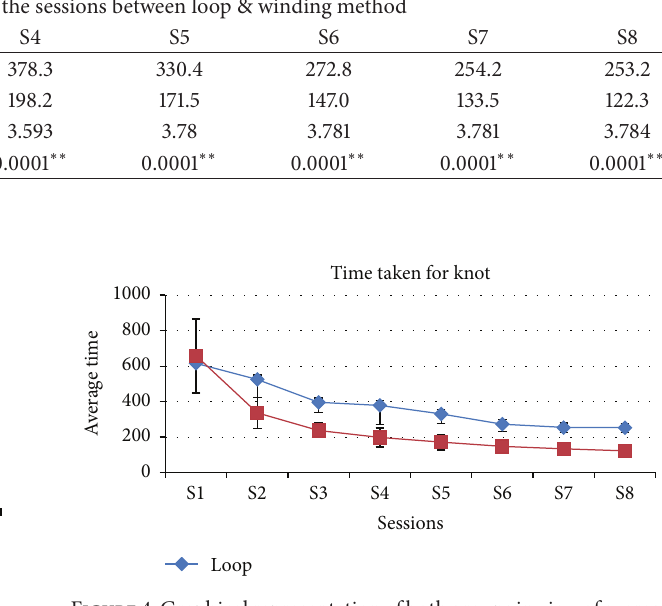
Table 2: Comparison of average time for one set of knots ( 2 × 1 × 1 ) in every session was done between groups A and B. Comparison of average time along the sessions between loop & winding method